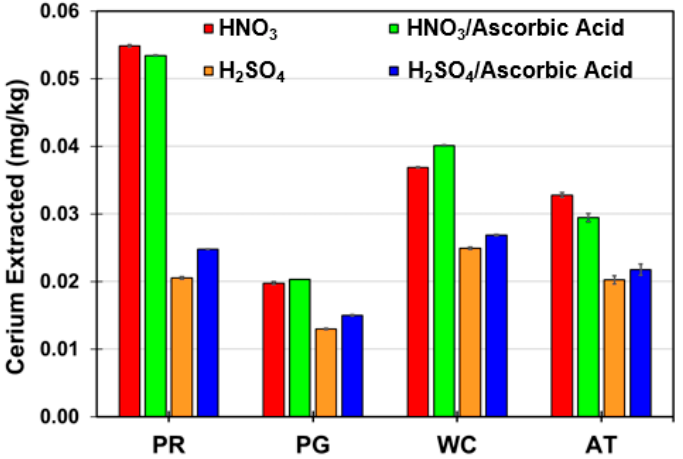
Figure 4. Extracted cerium levels with ascorbic acid.